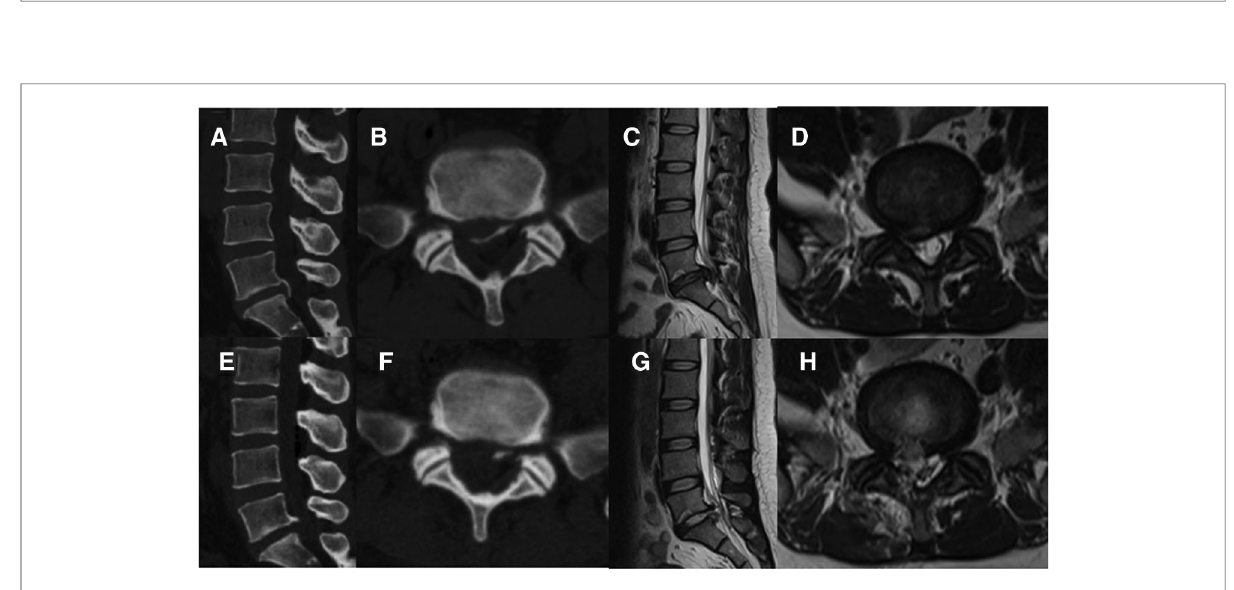
Table 1 . The mean operative time, intraoperative fl uoroscopy times, postoperative hospital stay, and intraoperative blood loss were 65.36 ± 5.26 min, 2.96 ± 0.88 times, 2.64 ± 1.16 days, and 13.21 ± 4.35 ml,